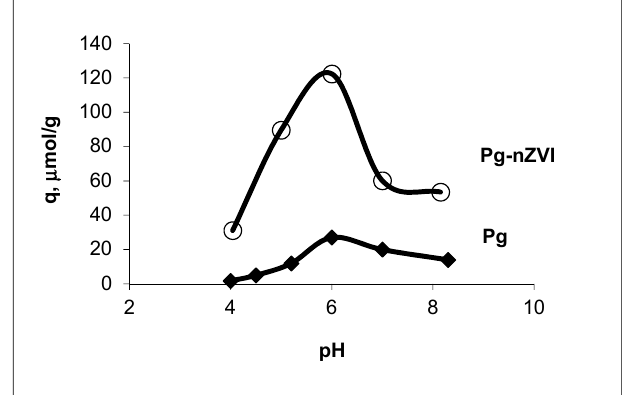
Figure 8. Sorption of U(VI) ions on pristine paligorskite and paligorskite- nZVI as a function of pH.